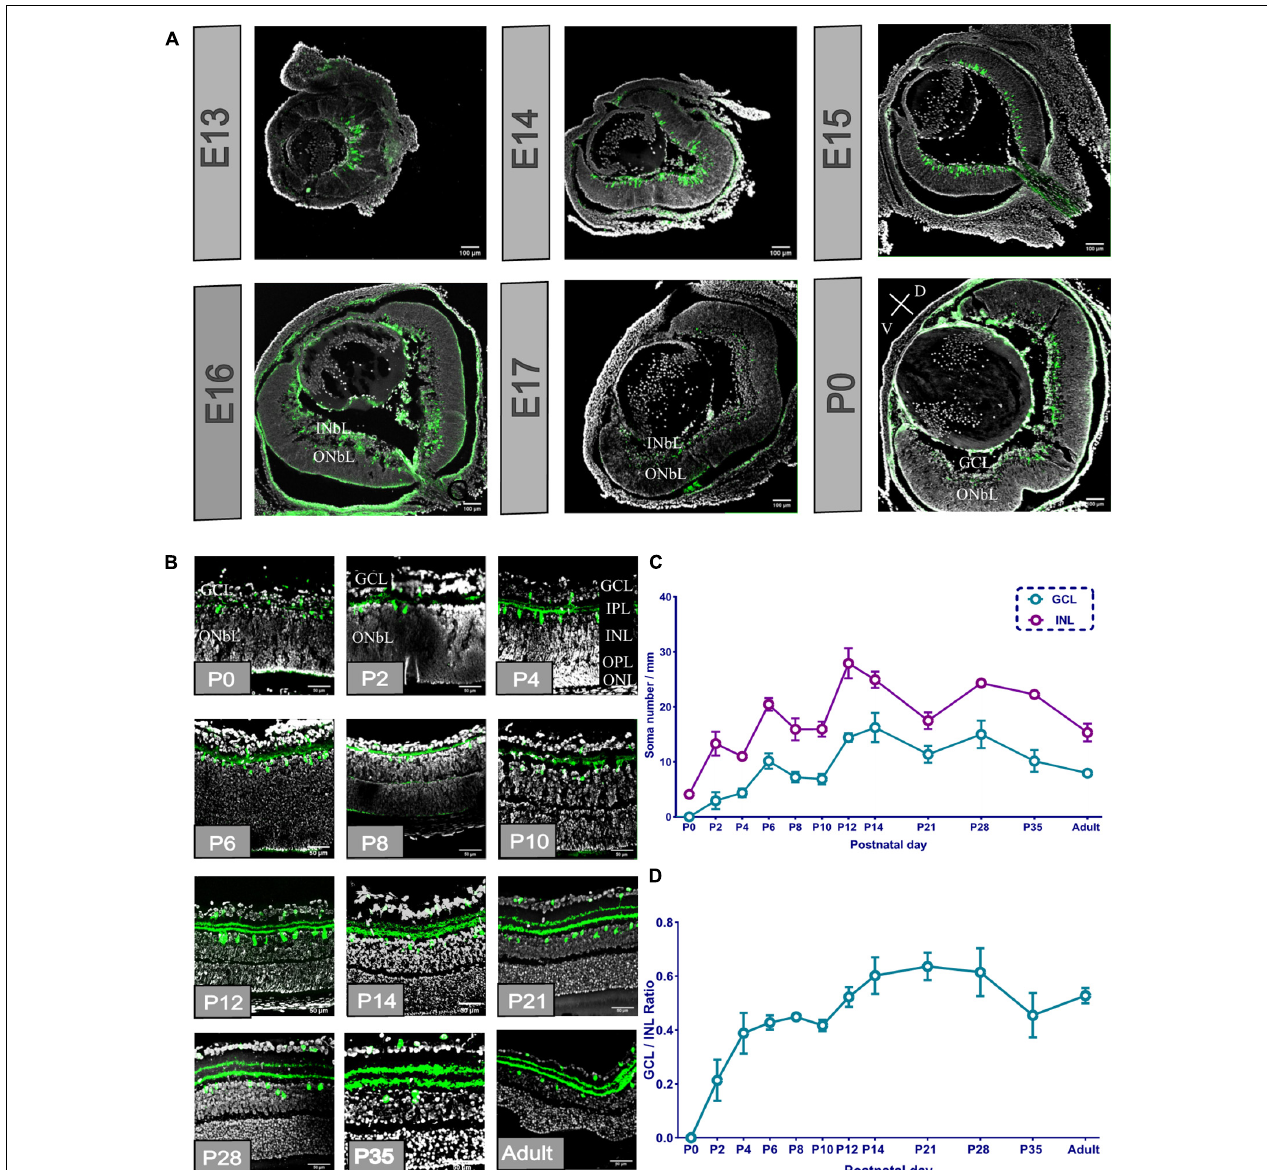
FIGURE 1 | Proopiomelanocortin-positive amacrine cell (POMC AC) soma divided into layers, and the soma number and retinal ganglion cell layer (GCL)/inner nuclear layer (INL) ratio increased from the retinal section from E13 to adult. (A) Whole ocular section of E13–P0. POMC-positive cells (green) appeared at E13; the distribution changed from E16. Bar = 100 µ m. Gray indicates DAPI. V indicates ventral retina, and D indicates dorsal retina. (B) P0-adult retina section. POMC-positive cell soma (green) divided into two layers at P2, and dendrites divided at P4 when the OPL appeared. Bar = 50 µ m. Gray indicates DAPI. (C) POMC-positive cell soma number analysis in the two layers. The GCL number was less than the INL number at all time points. Both layer numbers increased from P0 to P14 and were stable to the adult stage ( n = 12 for each timepoint). (D) GCL/INL number ratio. The ratio increased from P0 to P14 and kept stable to the adult stage at about 0.5 ( n = 12 for each